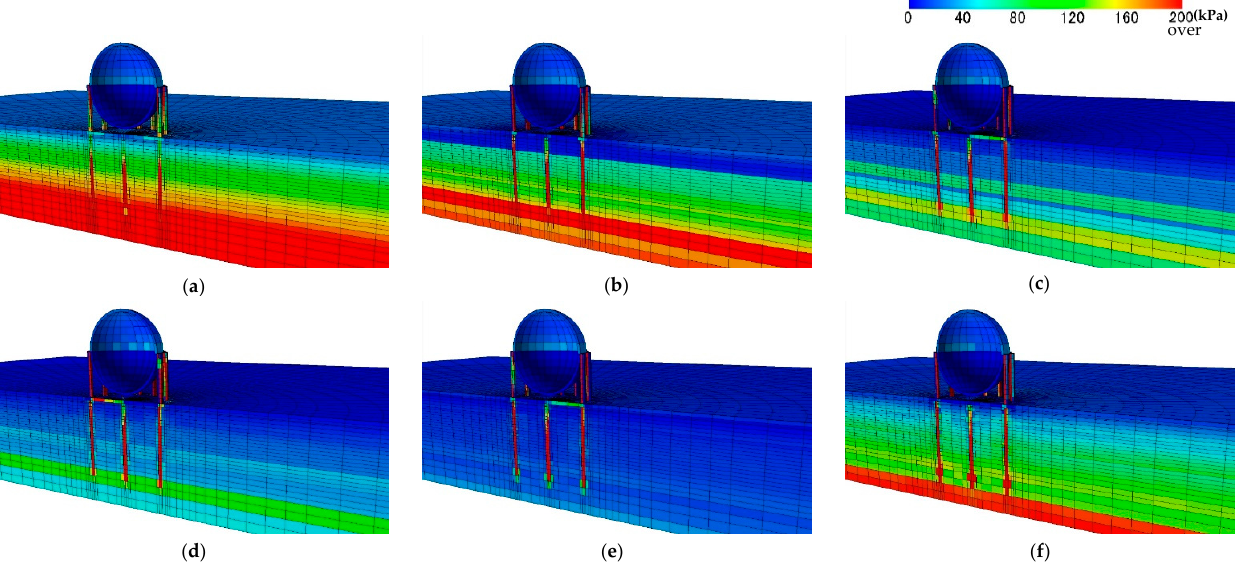
Figure 15. Change in mean effective stress over time, seismic motion (A): ( a ) immediately before the EQ; ( b ) 12 s after the start of the EQ; ( c ) 30 s; ( d ) 38.5 s; ( e ) end of the EQ; ( f ) end of consolidation (30 years after the EQ).